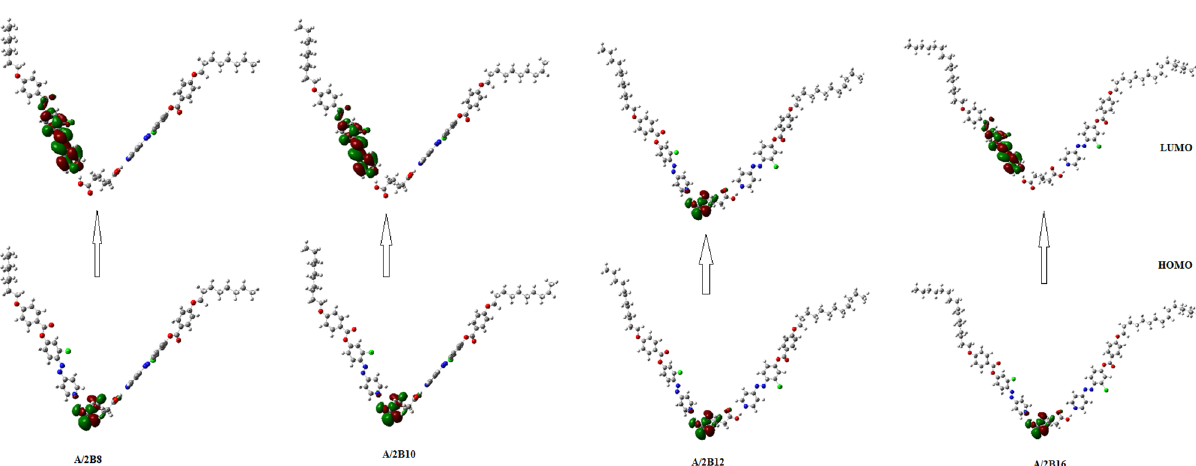
Figure 9. Predicted geometry for FMOs of conical-shaped series, A/2Bn